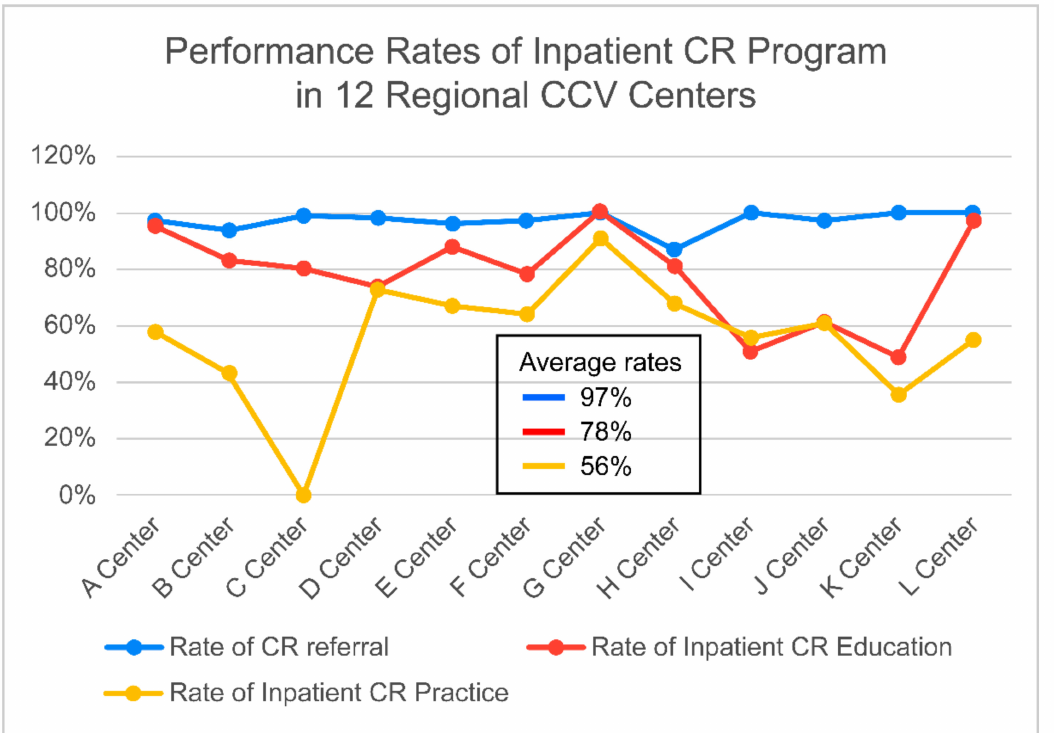
Figure 3. Performance Rate of Outpatient CR Program in 12 RCCs. CR: cardiac rehabilitation, RCC: Regional Cardiocere- brovascular